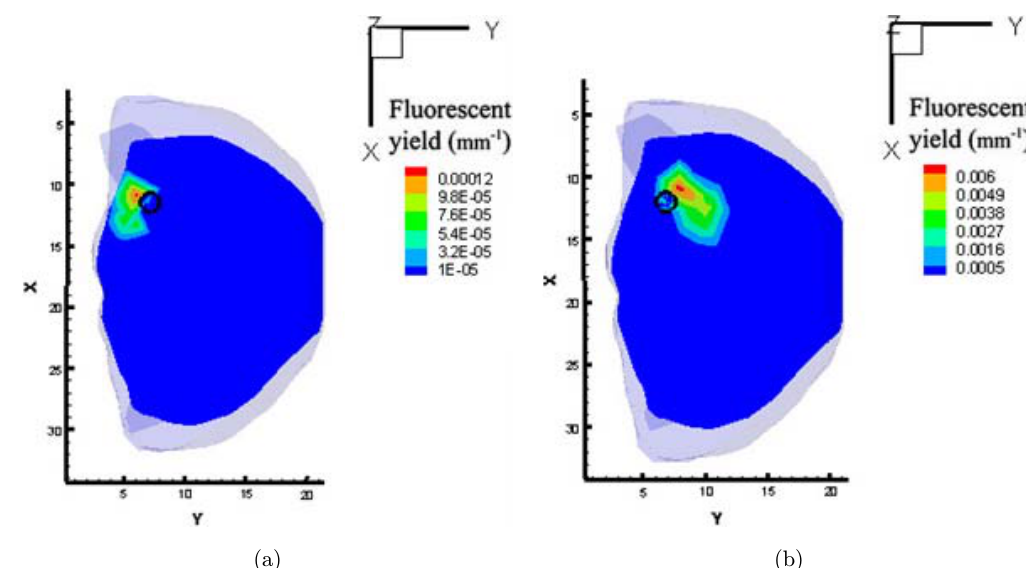
Fig. 3. Reconstructed results with di®erent forward models on the ¯rst mesh level. (a) SP N model. (b) DA